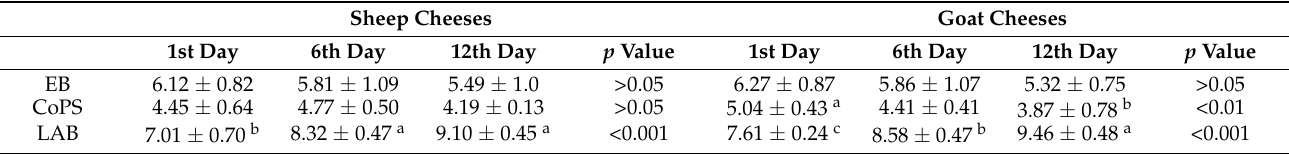
Table 6. Means and their standard deviations (mean ± SD) of the selected bacteria (log CFU/mL) in samples of sheep and goat cheeses at 1st, 6th, and 12th days of